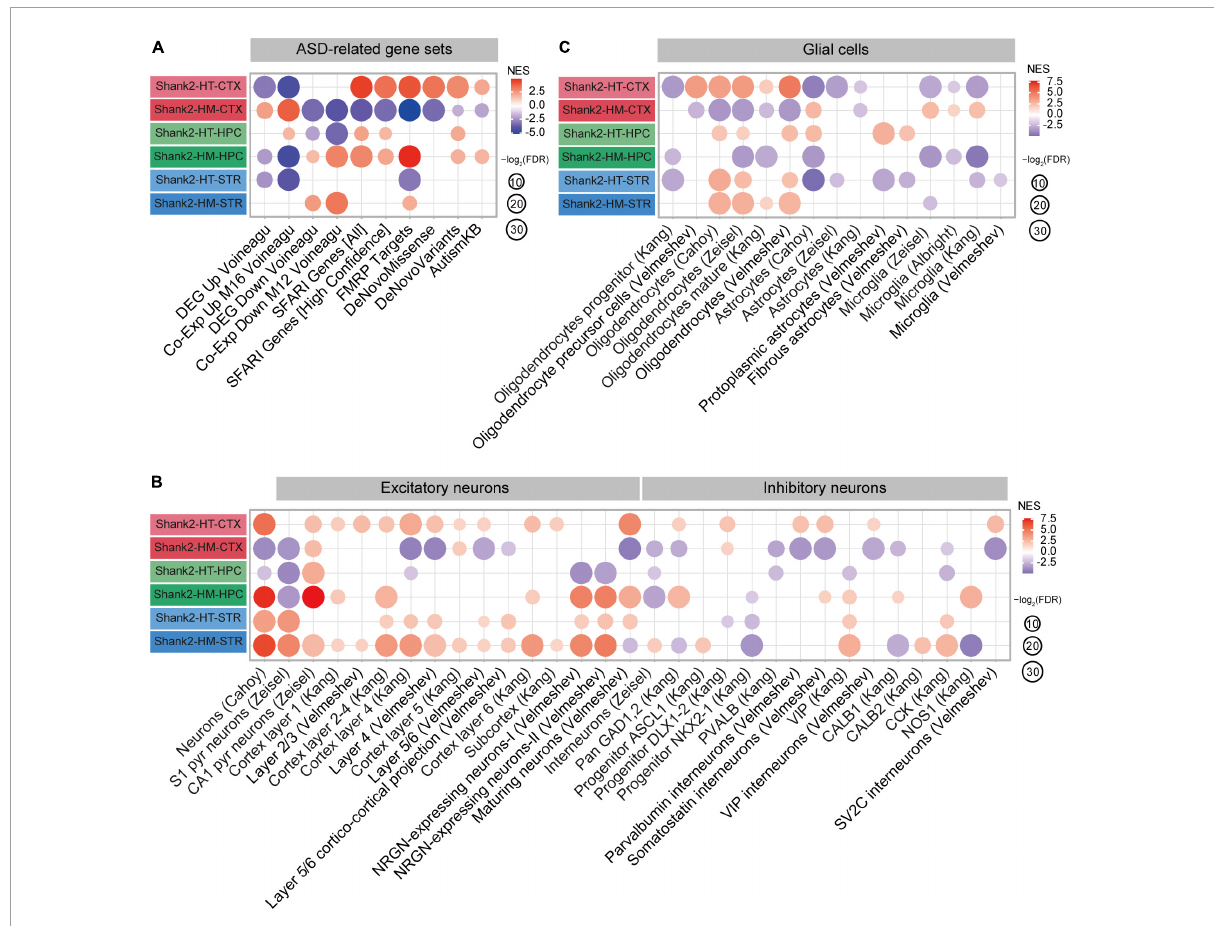
FIGURE5 Autism spectrum disorder (ASD)-related patterns revealed by gene set enrichment analysis (GSEA) of Shank2-heterozygous (HT) and Shank2-homozygous (HM) cortical/hippocampal/striatal transcripts. (A) GSEA results for Shank2-HT/HM cortical/hippocampal/striatal transcripts, as shown by enrichment patterns for ASD-related gene sets that are upregulated in ASD (DEG Up Voineagu and Co-Exp Up M16 Voineagu) and downregulated in ASD (DEG Down Voineagu and Co-Exp Down M12 Voineagu) and ASD-risk gene sets [SFARI genes (all), SFARI genes (high confidence), FMRP targets, DeNovo Missense, DeNovo Variants, and AutismKB; n = 5 mice (Shank2-HT/HM cortex, hippocampus, and striatum)]. (B) GSEA results for Shank2-HT/HM cortical/hippocampal/striatal transcripts, as shown by enrichment patterns for cell-type-specific gene sets (glutamate and GABA neurons; n = 5 mice for Shank2-HT/HM cortex/hippocampus/striatum). (C) GSEA results for Shank2-HT/HM cortical/hippocampal/striatal transcripts, as shown by enrichment patterns for cell-type-specific gene sets (glial cells) [ n = 5 mice (Shank2-HT/HM cortex, hippocampus, and